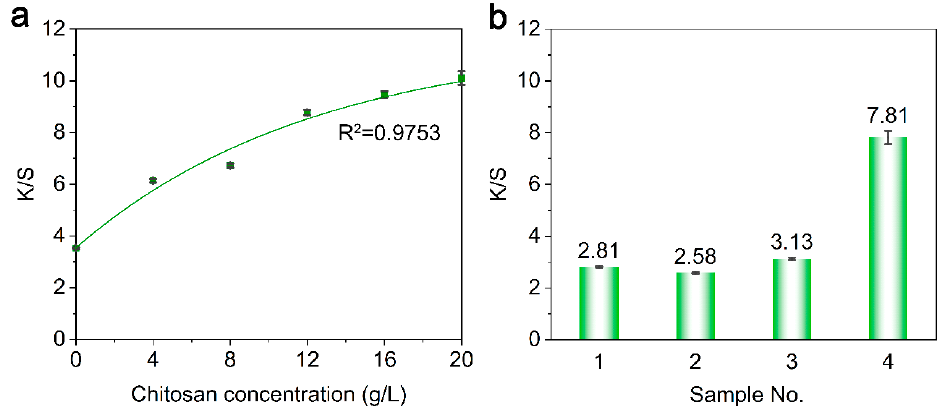
Figure 3. ( a ) K / S of fabrics treated with a chitosan solution with gradient concentrations; ( b ) K / S of fabrics treated with the chemicals detailed in Table 1.